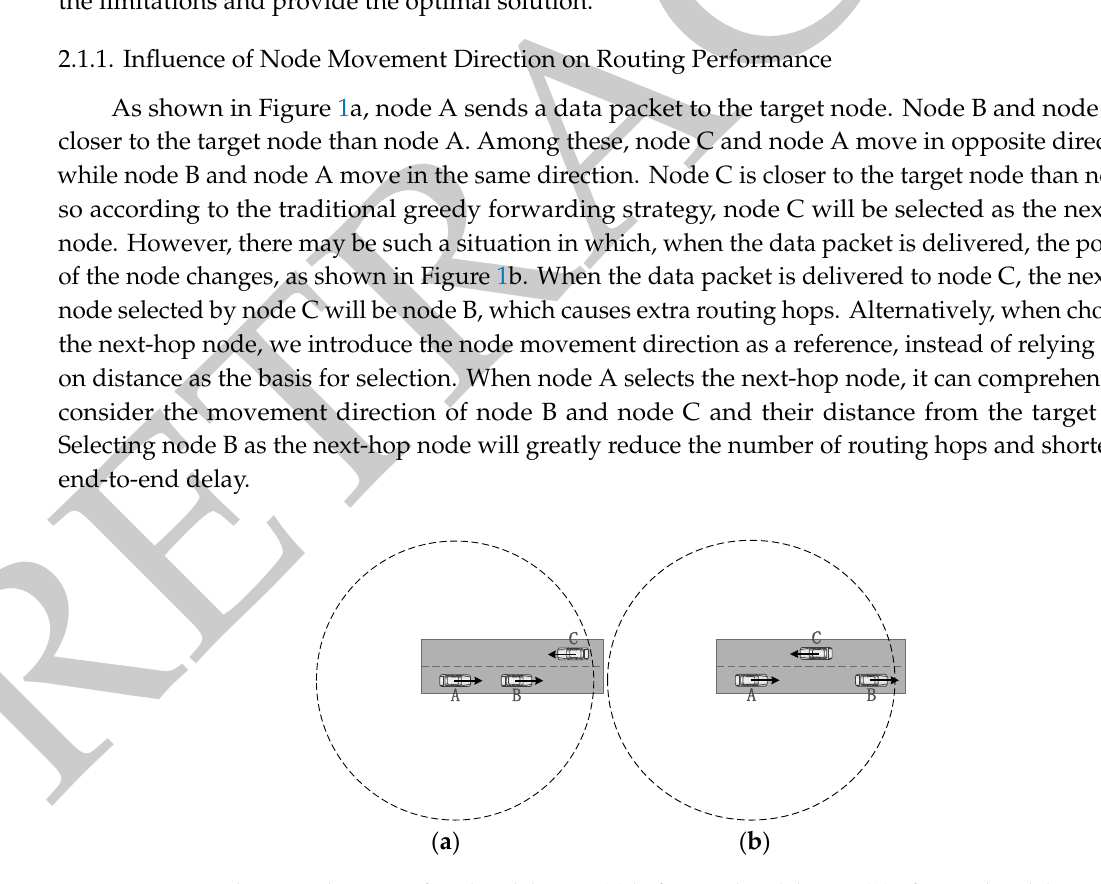
Figure 1. Schematic diagram of packet delivery: ( a ) before packet delivery; ( b ) after packet delivery.